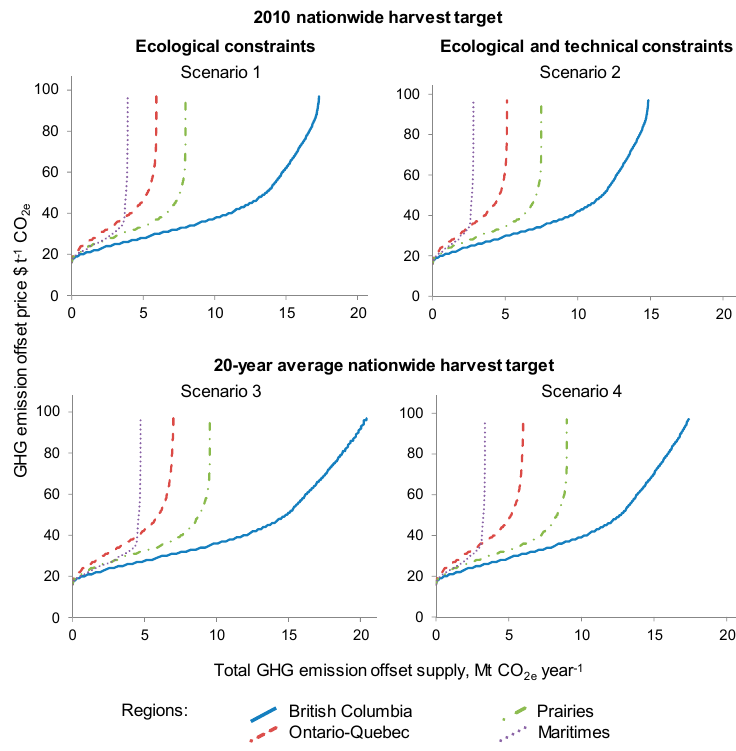
Figure 2. Regional greenhouse gas (GHG) emission offset supply curves. Coal substitution scenarios 1–4 are shown only. Prairies: Alberta, Saskatchewan, Manitoba, Maritimes: New Brunswick, Nova Scotia, Newfoundland.